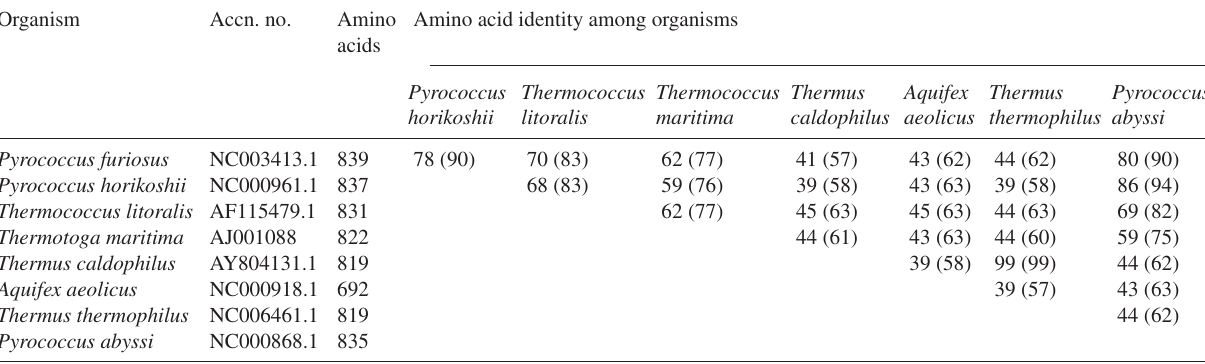
Table 1. Similarity matrix of amino acids pair wise identity for α -glucan phosphorylases from different thermophiles. Amino acid identity among organisms specifies the number of amino acid residues between each pair of organisms which are identical, with the percent of identical and simi- lar residues given in parentheses. Abbreviations: Accn. no., Accession number; and amino acids, number of amino acids. Organism Accn. no.